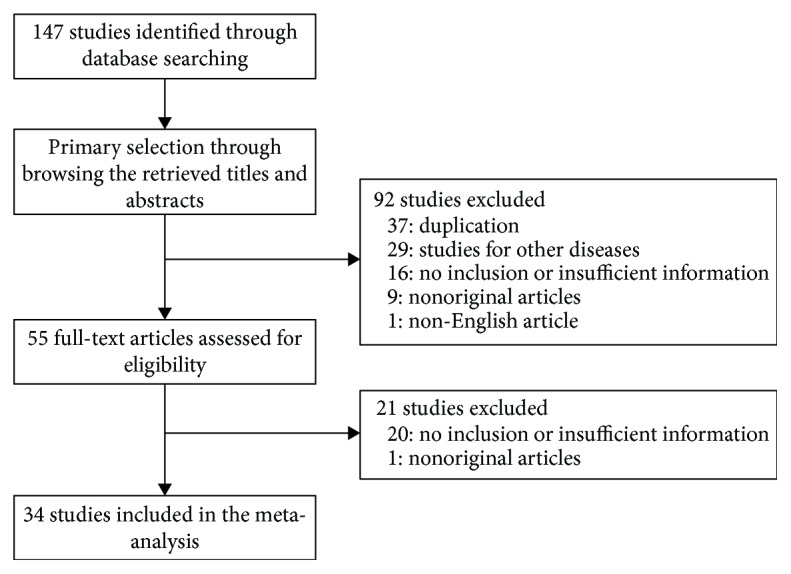
Flow diagram of the study selection process.